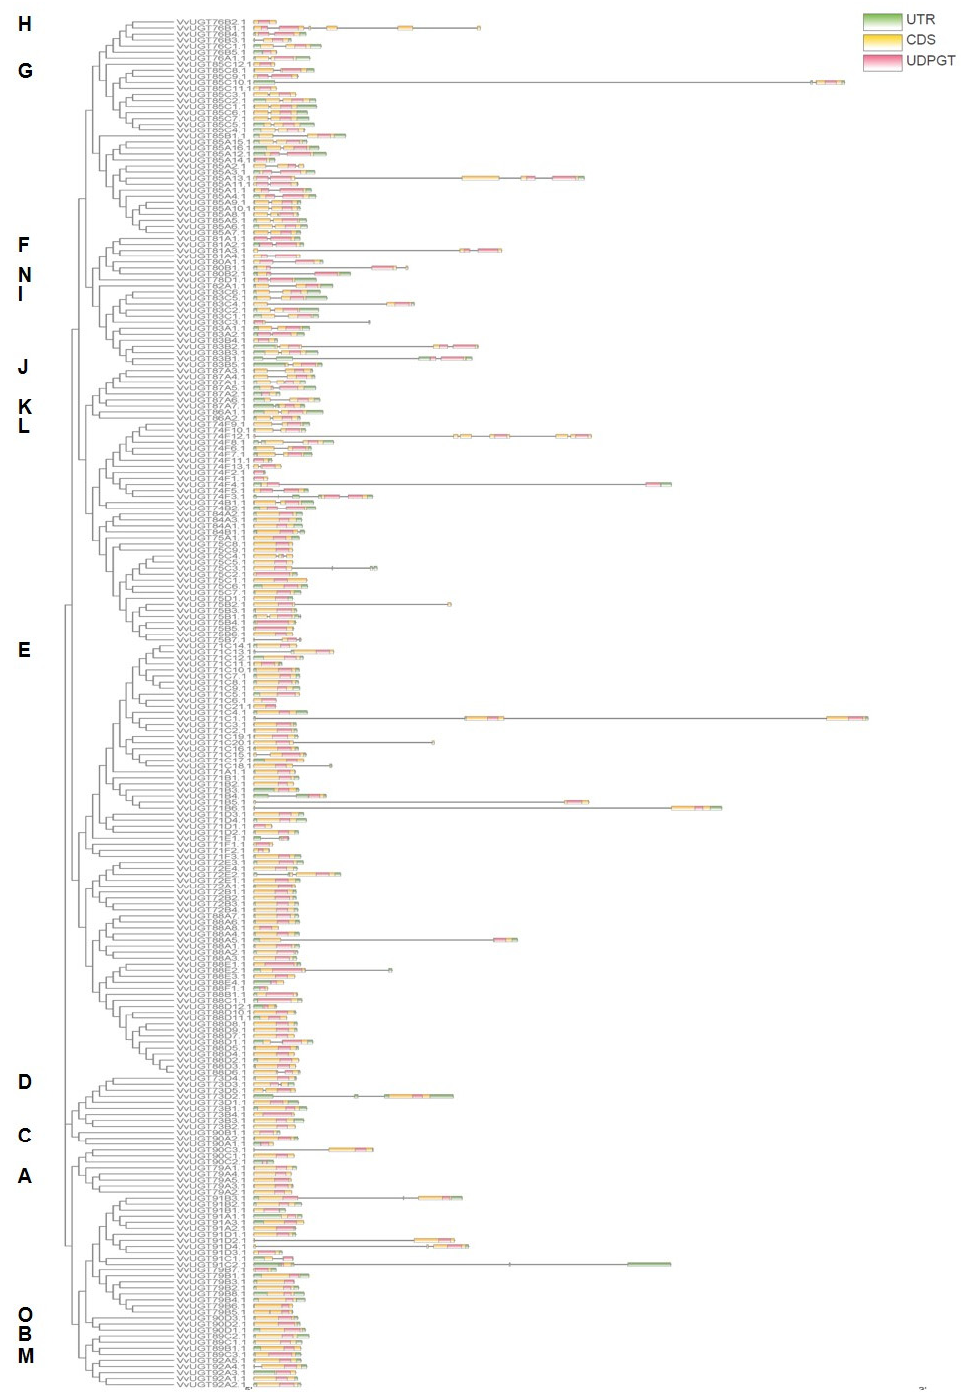
Figure 4. Analysis of gene structures among UGT genes in grapes.